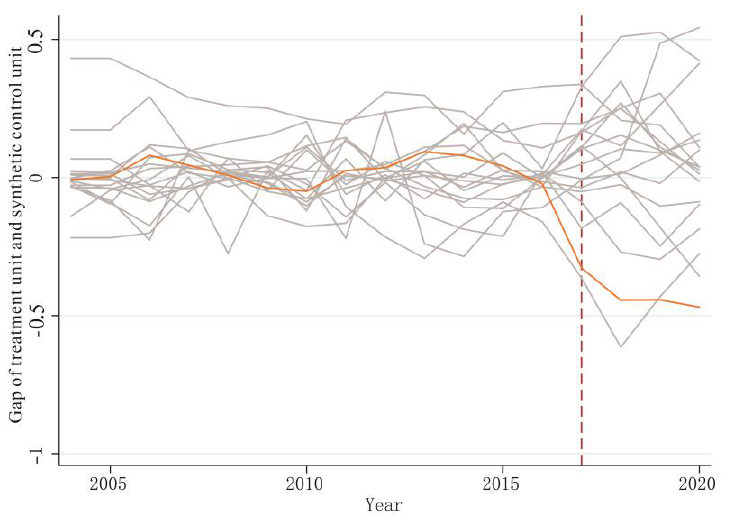
Figure 5. Industrial wastewater discharge gaps in the black land area and placebo gaps in the control regions.